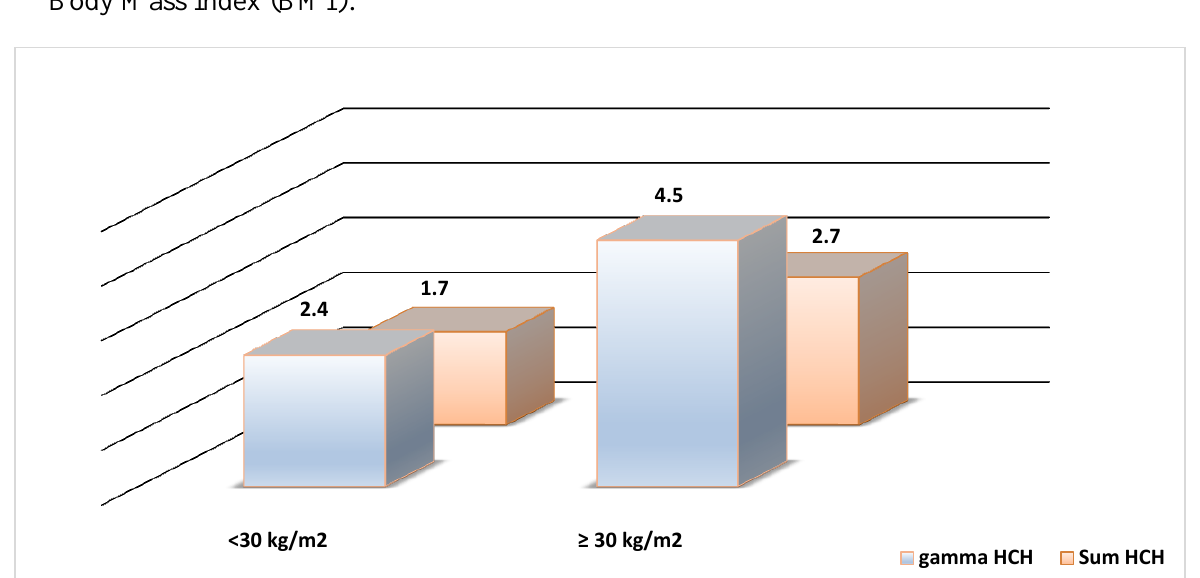
Figure 1. Odds ratios (OR) for Diabetes in gamma-HCH, sum HCH and two levels of Body Mass Index